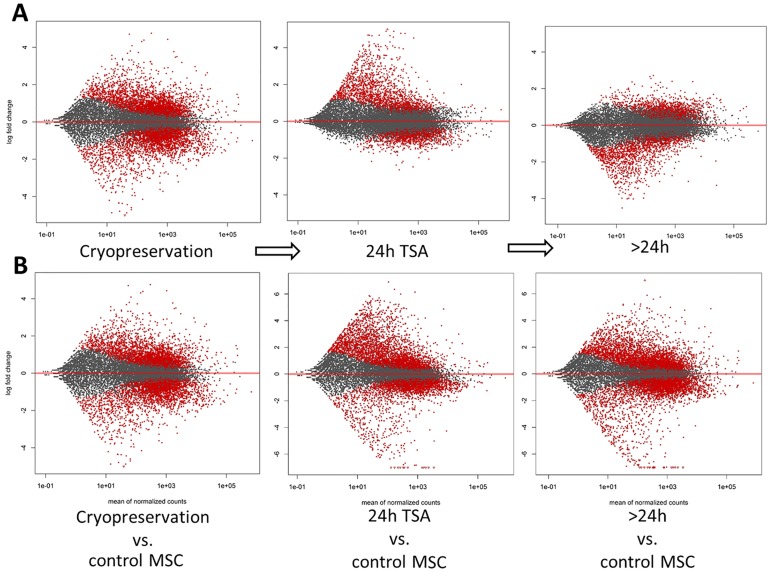
Log2 fold change and the mean expression level for all genes in the studied MSCs.Significantly differentially expressed genes are marked in red, A- in comparison to preceding treatment; The genes expression level was compared between the frozen and non-frozen control, the TSA treated cells and frozen control and the cells further cultured following TSA removal vs. the TSA treated cells; B- in comparison to the fresh (non-frozen) MSCs.